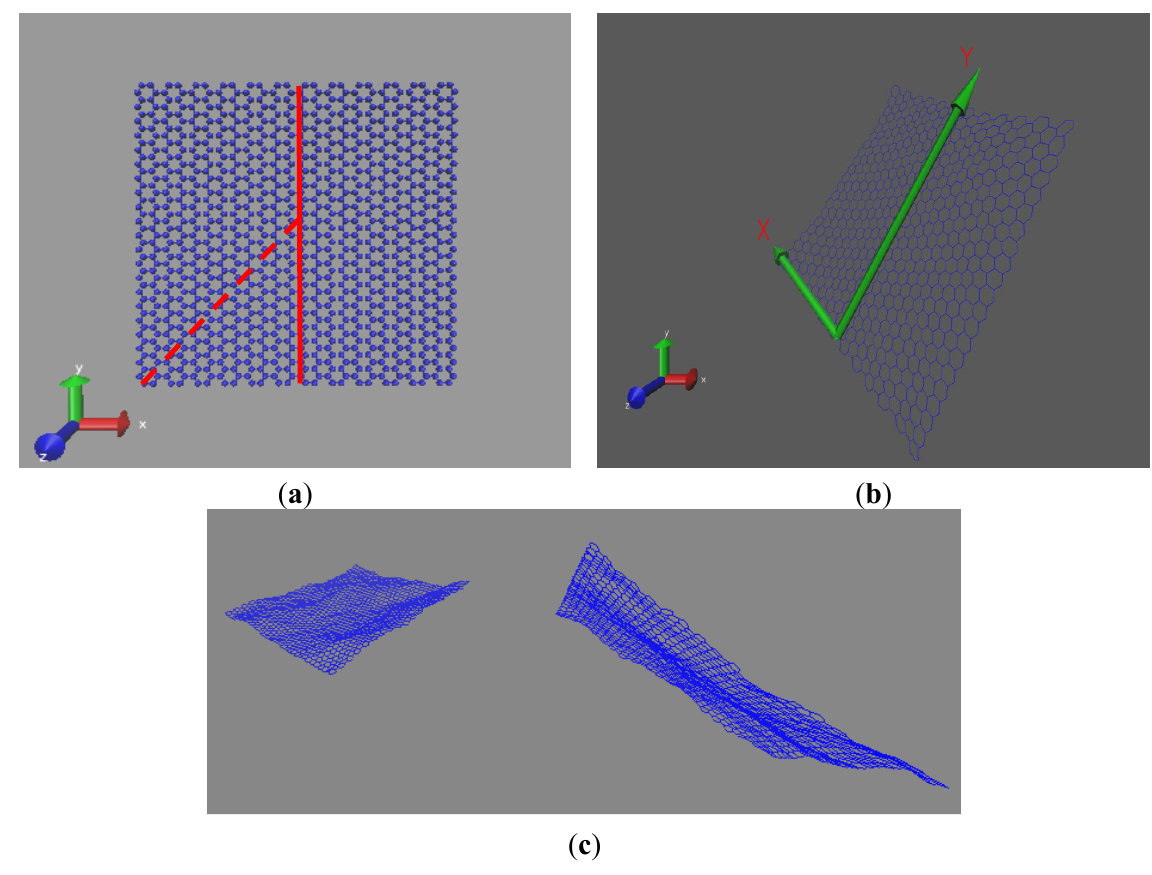
Figure 14. ( a ) A schematic representation for the conformational analysis of graphene sheets. The characteristic vector along the half diagonal is shown; ( b ) A schematic representation for the Eulerian transformation of the coordinates from the original Cartesian system to a new one at the instantaneous position of the sheet; ( c ) A characteristic snapshot of graphene layers with